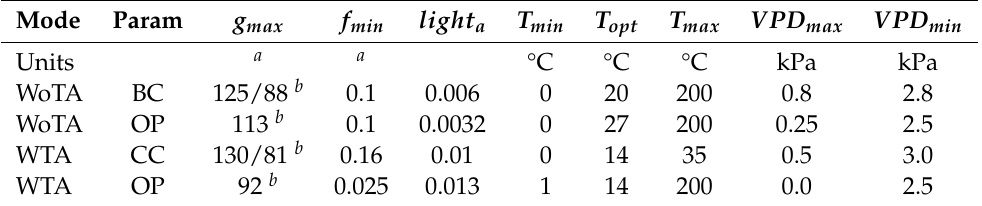
Table 5. Selected parameterizations of the modified Jarvis model with the best evaluation of the model